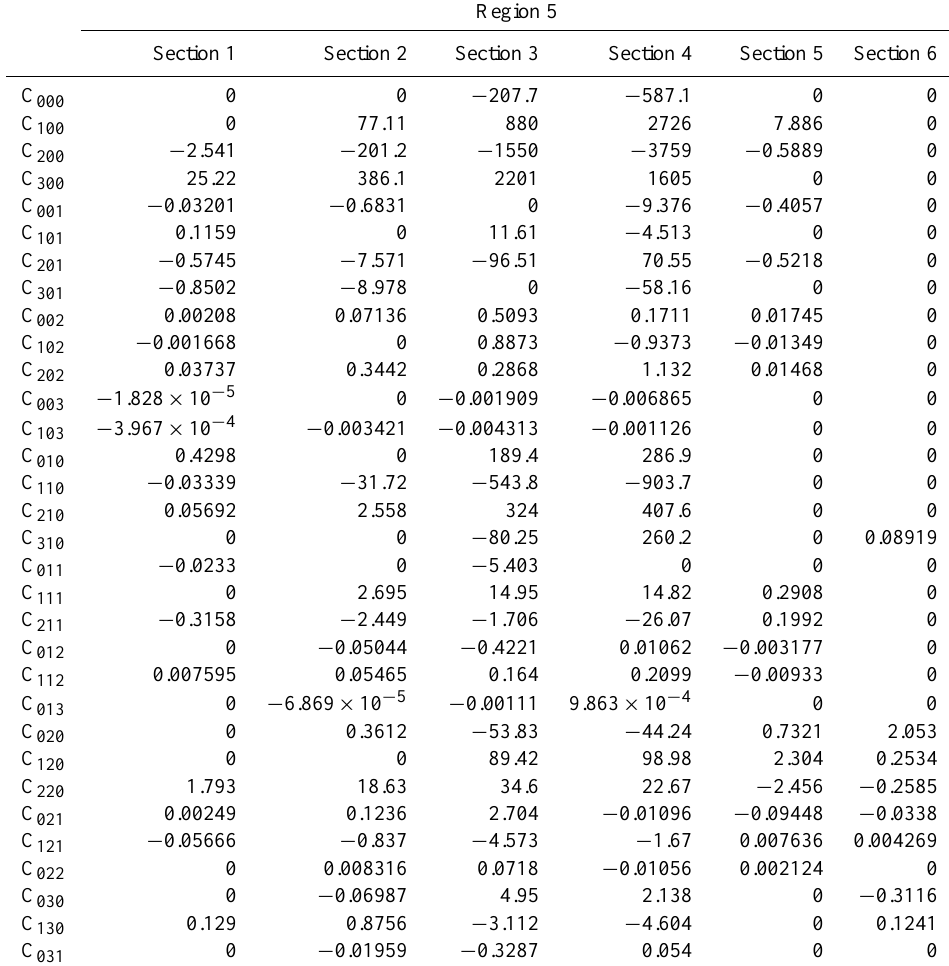
Table 7. Similar to Table 3, but for region